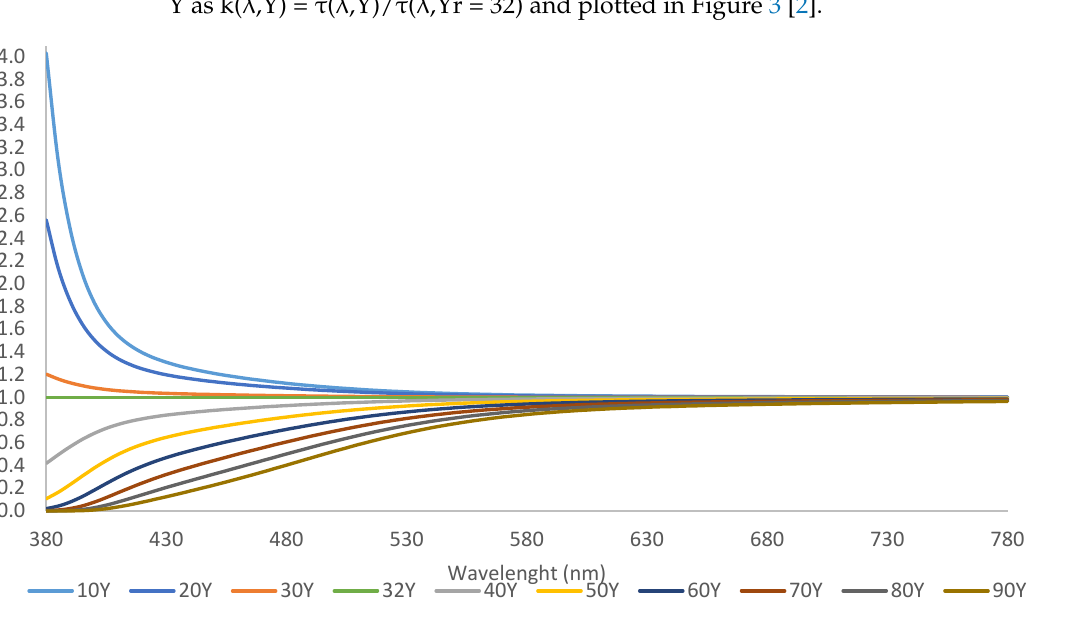
Figure 3. Age-related spectral correction function k( λ ,Y) defined for an observer of age Y and spectrum modified by the absorption of the anterior media of the eye, shifted for different-aged observers (from 10 to 90 years old). Reproduced from [2].